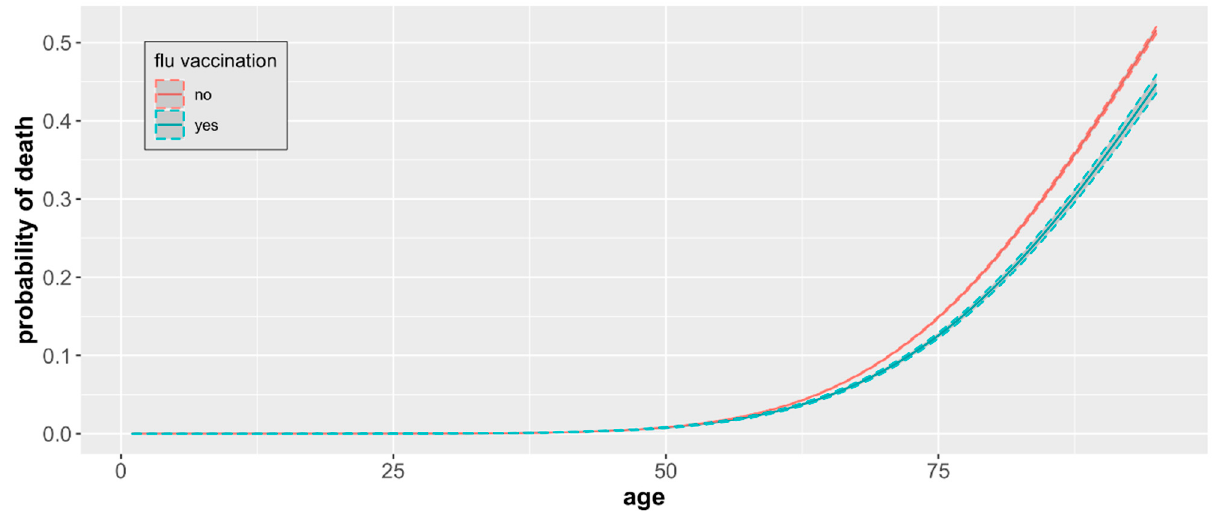
Figure 4. COVID-19 mortality by age and vaccination status. The probability of death from COVID-19 by age and influenza vaccination status based on a sample of 93,208 cases with observed mortality outcomes with 95% CIs.